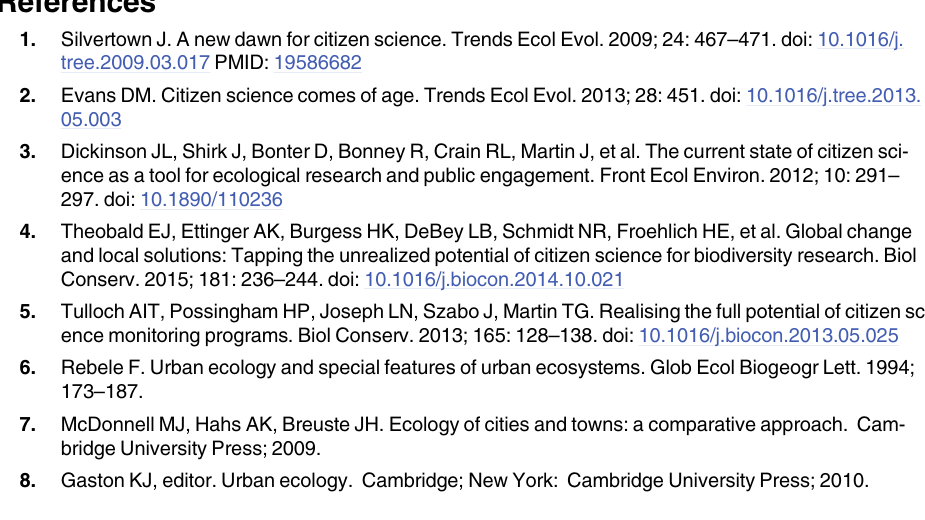
S1 Table. PRISMA checklist for systematic review. S2 Table. Summary diagram of the methodological and logical framework applied in this review. UE: Urban Ecology, CS: Citizen Science, NDMS: Non-metric multidimensional scal-